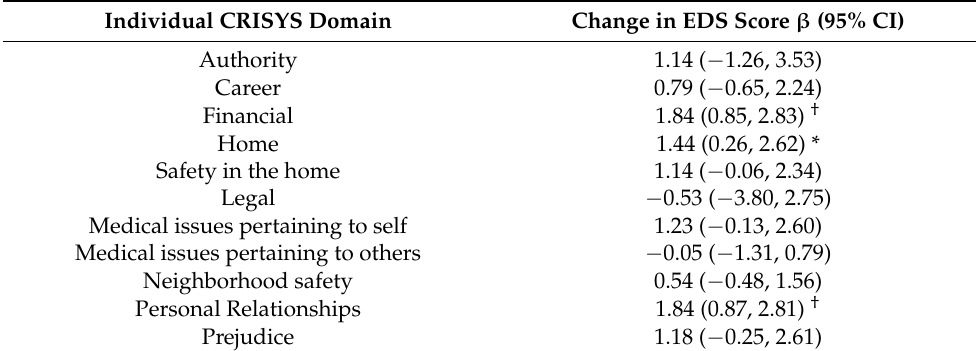
Figure 2. Association between odds of depression, stress and social support during the pandemic. Model adjusted for NLE and social support score at baseline and during the pandemic, SES and depression at baseline and age during pandemic. Table 2. Associations between reporting of any negative life event in individual domains during the pandemic and change in EDS